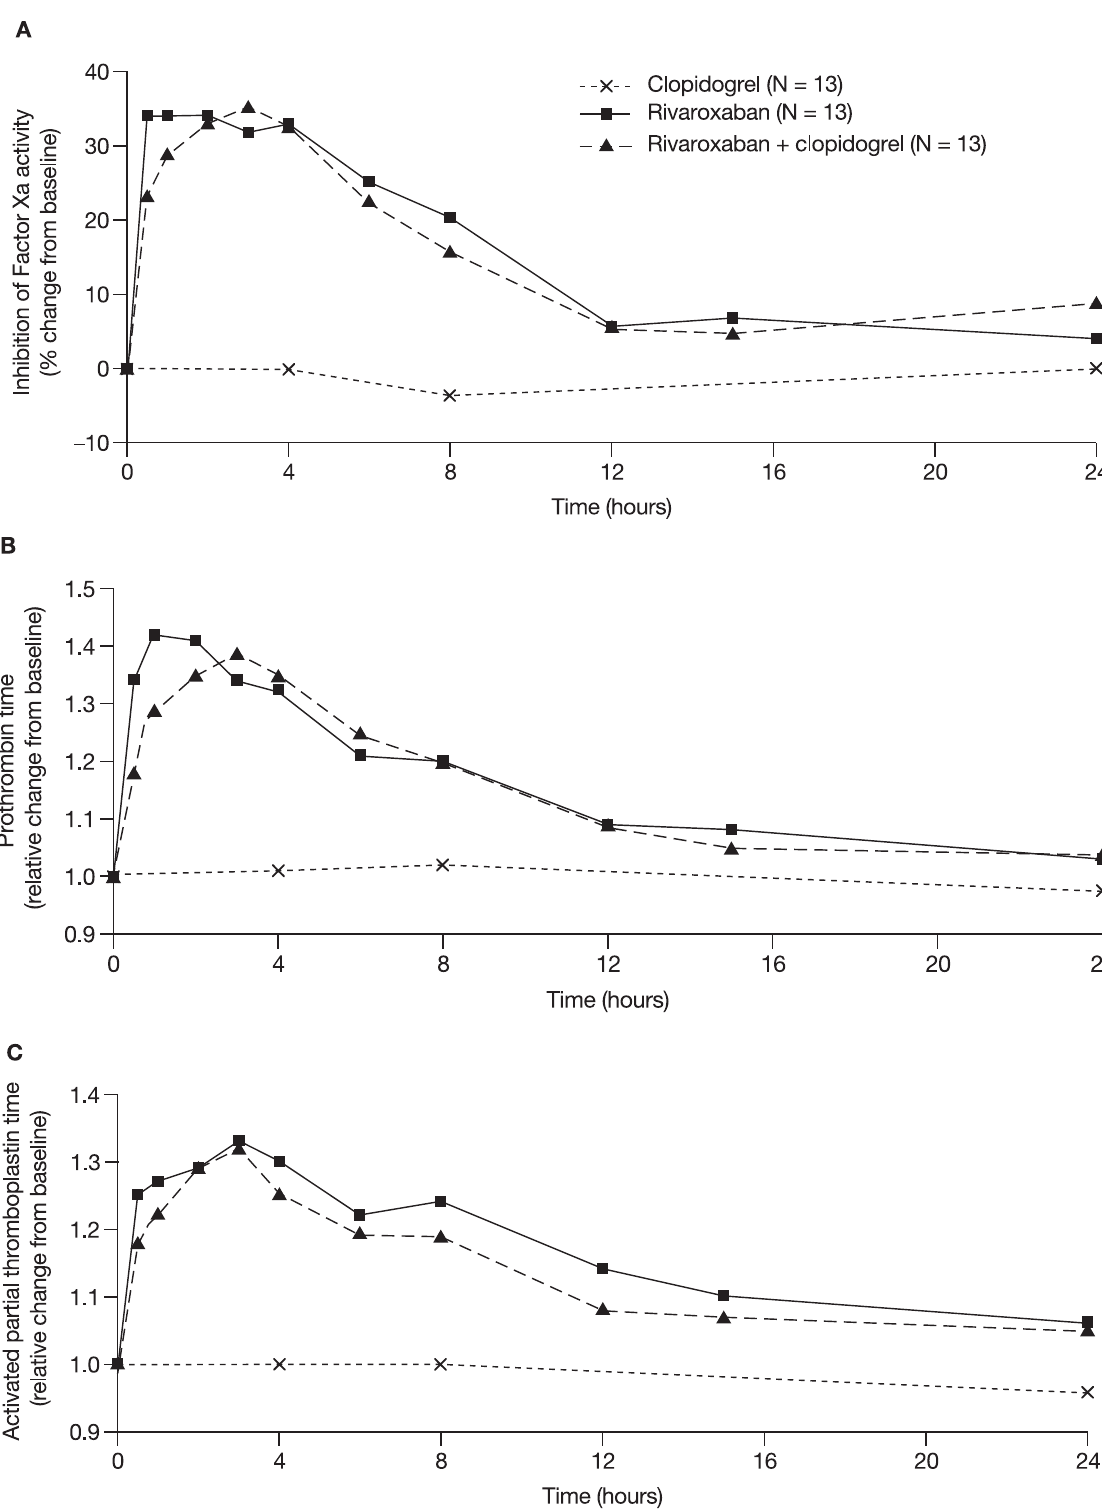
Figure 3. Pharmacodynamic parameters. The effect of rivaroxaban and clopidogrel alone and in combination on ( A ) the median percentage change from baseline of the inhibition of Factor Xa activity over time; ( B ) Median relative change from baseline of prothrombin time over time; ( C ) Median relative change from baseline of the activated partial thromboplastin time over time; ( D ) Median relative change from baseline of the HepTest over